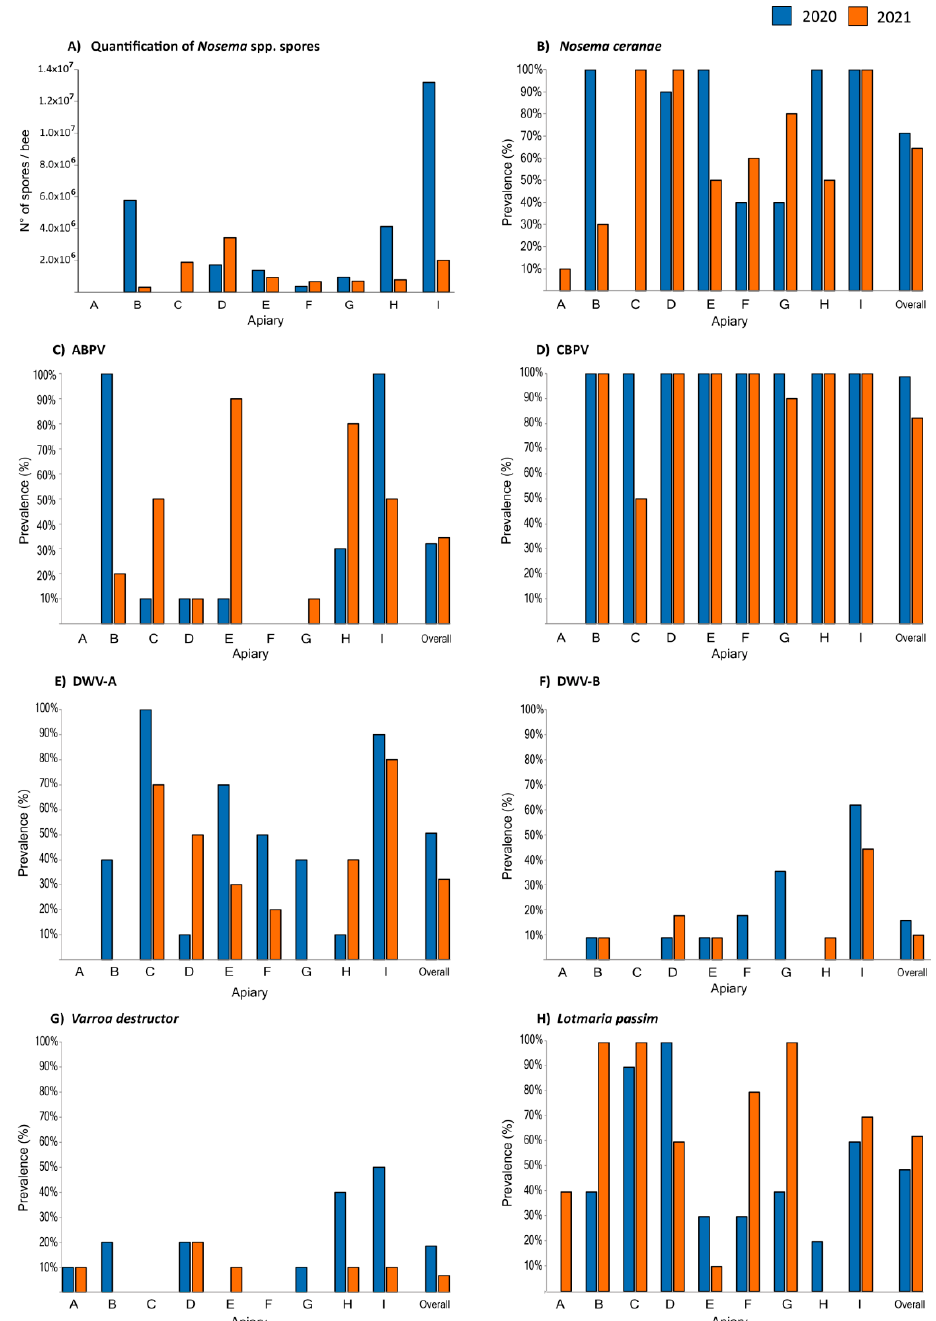
Figure 2. Number of Nosema spp. spores and overall pathogens’ prevalence in sampled apiaries (from A to I). Panel ( A ): mean number of Nosema spp. spores per bee, detected in the sampled apiaries both in 2020 (blue bars) and 2021 (orange bars), is shown. Panels ( B – H ): frequencies (in percentage) of N. ceranae ( B ), ABPV ( C ), CBPV ( D ), DWV-A ( E ), DWV-B ( F ), V. destructor ( G ) and L. passim ( H ), detected in the sampled apiaries and in the overall population both in 2020 (blue bars) and 2021 (orange bars), are presented. N. apis , IAPV and KBV prevalence are not shown because all the analysed samples were negative. C. mellificae prevalence is not shown because positive honey bees were found only in one hive of apiary B in 2020. SBV prevalence is not shown because all the analysed samples resulted positive. BQCV prevalence is not shown because all the analysed samples resulted positive in 2020, and 97.8% of all hives (only two hives in apiary A were negative) resulted positive in